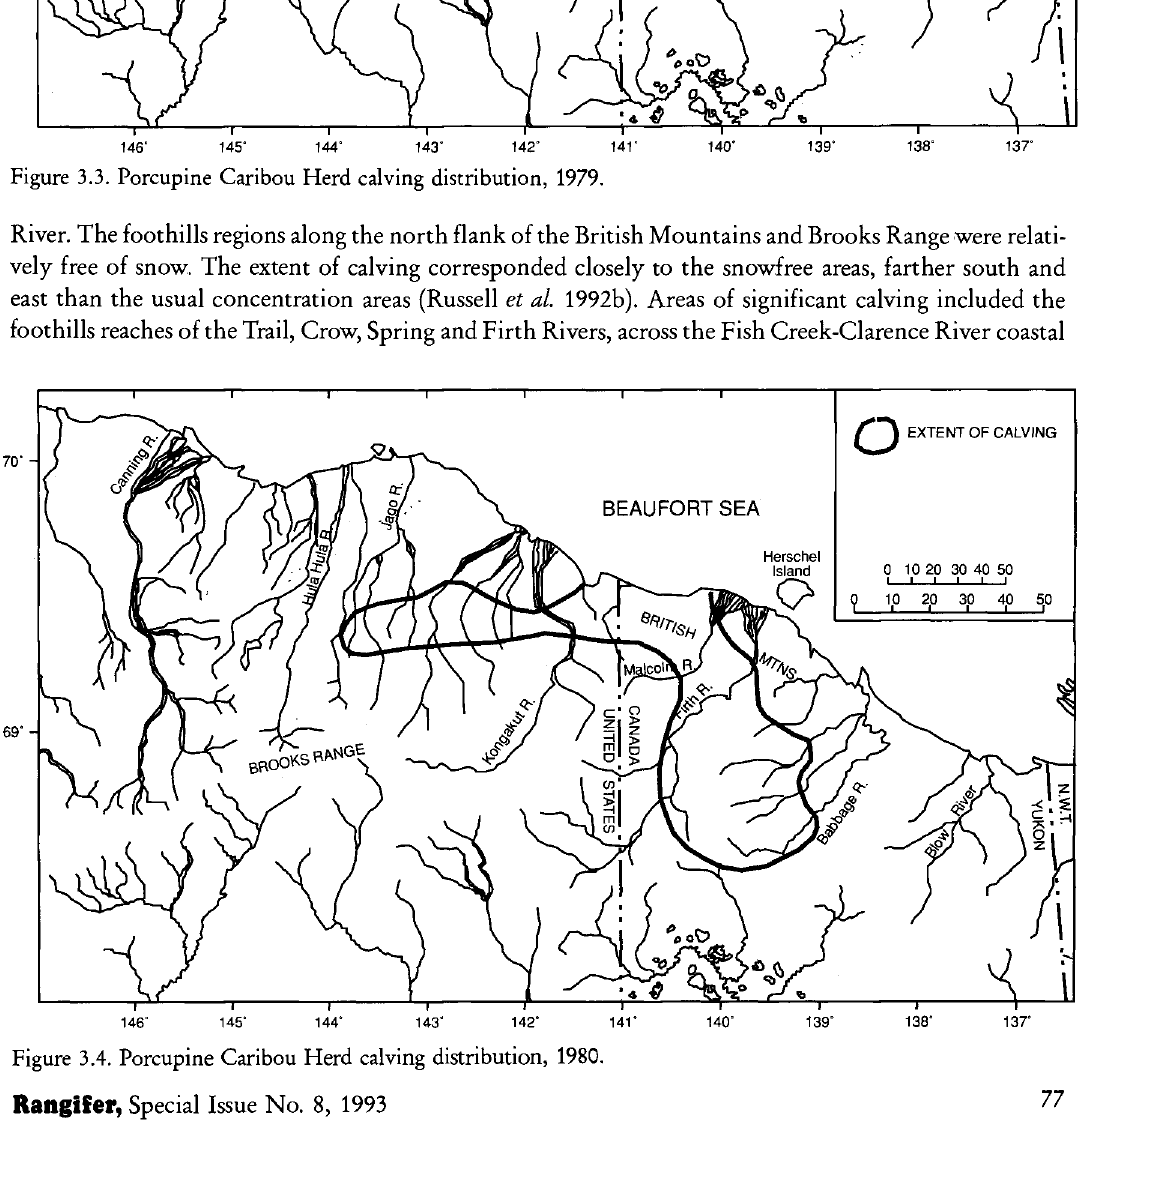
Figure 3.4. Porcupine Caribou Herd calving distribution,